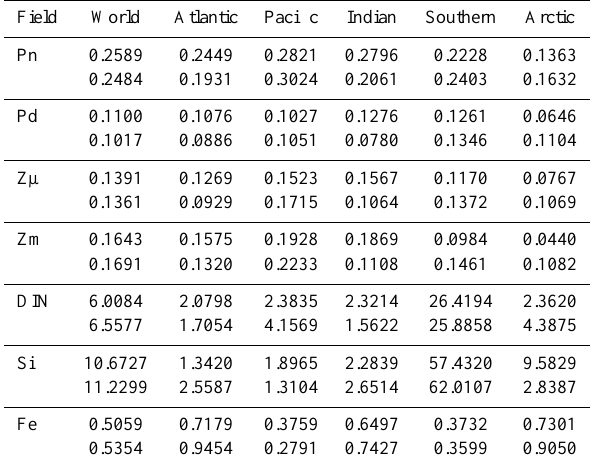
Table 7. Mean annual (2000–2004) surface concentrations